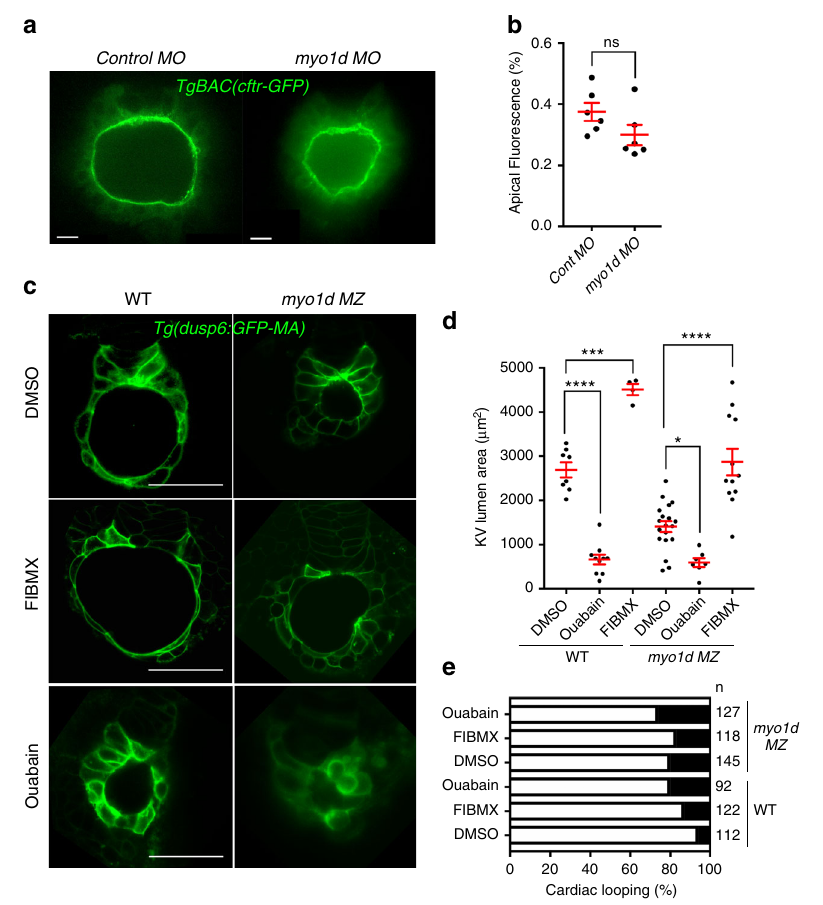
Fig. 5 Modulating Cftr activity restores lumen size in myo1d MZ mutant embryos. a, b Knockdown of myo1d in TgBAC(Cftr-GFP) embryos did not affect CFTR apical GFP localization ( n = 6 control MO, n = 6 myo1d MO). c – e Activation of Cftr function in the absence of myo1d MZ mutant expanded lumen area. Representative Z-stack image showing that Forskolin and IBMX (FIBMX) increased KV lumen in WT and myo1d MZ embryos ( c ). Treating with ouabain, an inhibitor of Na + /K + ATPase decreased the KV lumen area in WT and myo1d mutant embryos. Numeration of lumen area with treatments are shown in (WT-DMSO: n = 8, WT-ouabain: n = 10, WT-FIBMX: n = 4, myo1d MZ -DMSO): n = 19, myo1d MZ -ouabain: n = 7, myo1d MZ -FIBMX: n = 12) ( d ). Cardiac looping defects were increased in WT embryos treated with FIBMX or ouabain but did not increase in myo1d MZ mutants ( e ). Unpaired t test and one-way ANOVA were conducted. * p < 0.05, *** p < 0.001, **** p < 0.0001 represents statistical signi fi cance. ns not signi fi cant. Data shown are mean ± SEM. L lumen, scale bar = 15 µ m ( a ), 50 µ m ( c plasmids were used to generate mRNAs using SP6 mMessage mMachine kit zebra fi sh embryo were performed at desired stages using standard zebra fi sh (Ambion: AM1340) and puri fi ed using Roche mini quick spin RNA columns (Roche: protocols 50 . For dand5 quanti fi cation, right to left ratio for 8S stage embryos in 11814427001, USA). Each mRNA TALEN pairs were co-injected into 1-cell stage WT and myo1d MZ were calculated using ImageJ. dand5 insitu expression embryos and raised to adults. Somatic and heritable TALEN induced mutations were domains on either side of embryonic midline were measured after fi tting a region evaluated by using forward ( myo1d-F1 : 5 ′ -TTGCTGCAGGTTTGAAAAGGGTC of interest. Further, a ratio of right- vs left-sided expression region were derived GTA-3 ′ ) and reverse ( myo1d-R1 : 5 ′ -CAGTCTACCTGAGATGACAATGCACG-3 ′ ) to asses if KV function is compromised. This protocol was adapted from ref. 51 to using primers and One Taq DNA polymerase (NEB: MO0480S). PCR was performed describe KV function. using following cycling conditions: initial denaturation 4min 95°C, 35 cycles (30S 95 °C, 30S 58°C, 30S 68°C) and fi nal extension 5min 68°C. A 226bp PCR amplicon generated from 48hpf embryos were used to detect disruption of AatII restriction site in the myo1d target site by restriction fragment length polymorphisms. Founders harboring mutant alleles were outcrossed to generate F1 population and sequence veri fi ed. Positive F1 heterozygotes were in-crossed to generate homozygous zygotic (Z) mutants. Maternal zygotic ( MZ ) mutants are generated by in-crossing homo- zygous parents.